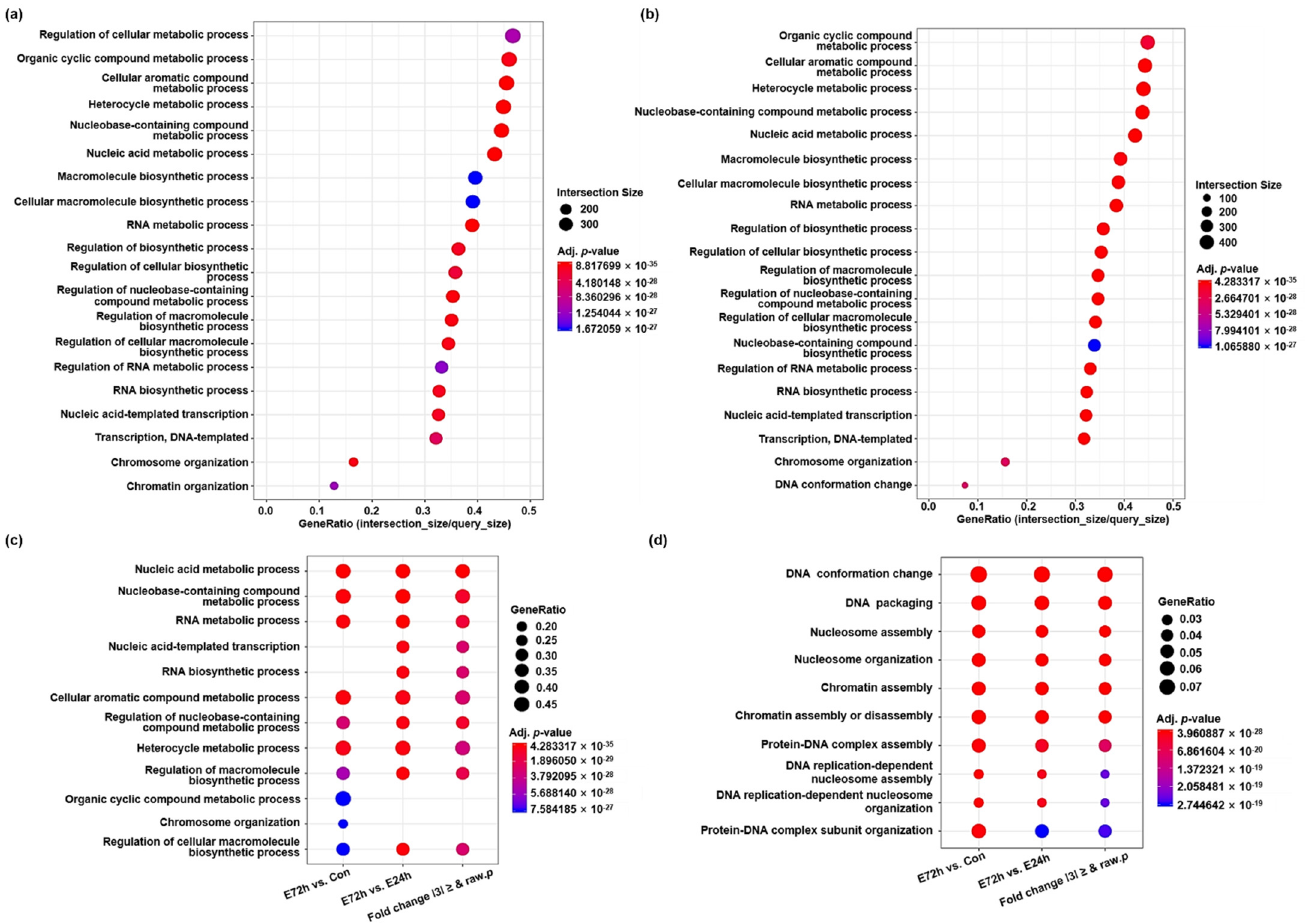
Figure 2. Gene ontology (GO) annotation of DEGs among control and ethanol-treated groups. En- richment and functional annotation of DEGs among control, E24h, and E72h groups were performed using g:Profiler. ( a ) Top 20 enriched GO terms in the biological process (BP) category of genes expressed differentially in E72h compared to the control. ( b ) Top 20 enriched GO terms in the BP category of genes expressed differentially in E72h compared to E24h. ( c ) Top 10 GO terms in the BP category obtained among comparison pairs. ( d ) Top 10 GO terms in the BP category obtained per comparison pair according to term size. Query size: the number of unique DEGs annotated to the data source. Intersection size: the number of unique DEGs annotated to the term ID.